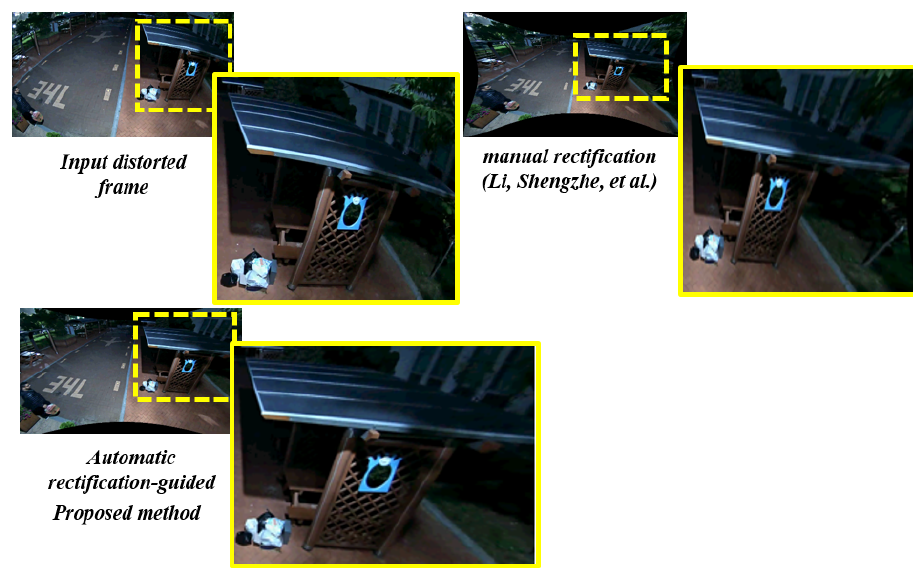
Figure 20. Robustness of proposed distortion-rectification-guided height estimation on wide-angle camera at night time.